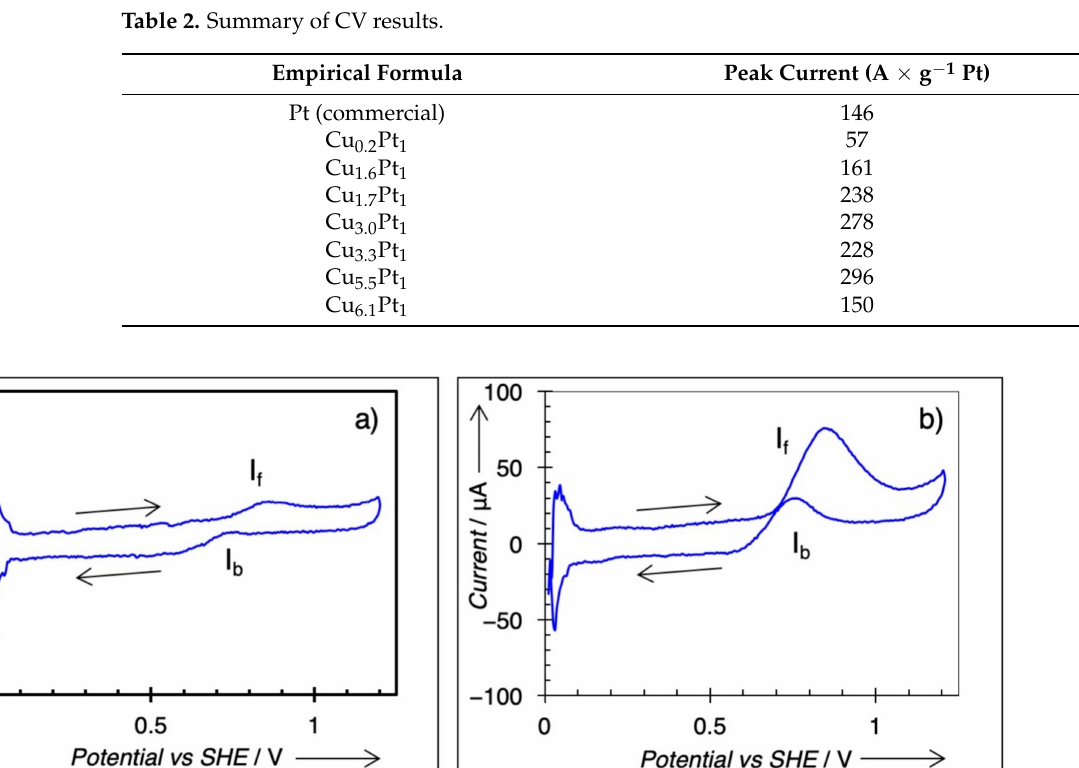
Figure 6. Cyclic voltammetry CV) traces for ( a ) Cu 0.23 Pt and ( b ) Cu 1.6 Pt. Forward scan peak current (I f ) at 0.85 V used for comparison of catalysts. Cyclic voltammetry in 0.5 M H 2 SO 4 , 1 M methanol, scan rate 5 mV/s, at 25 ◦